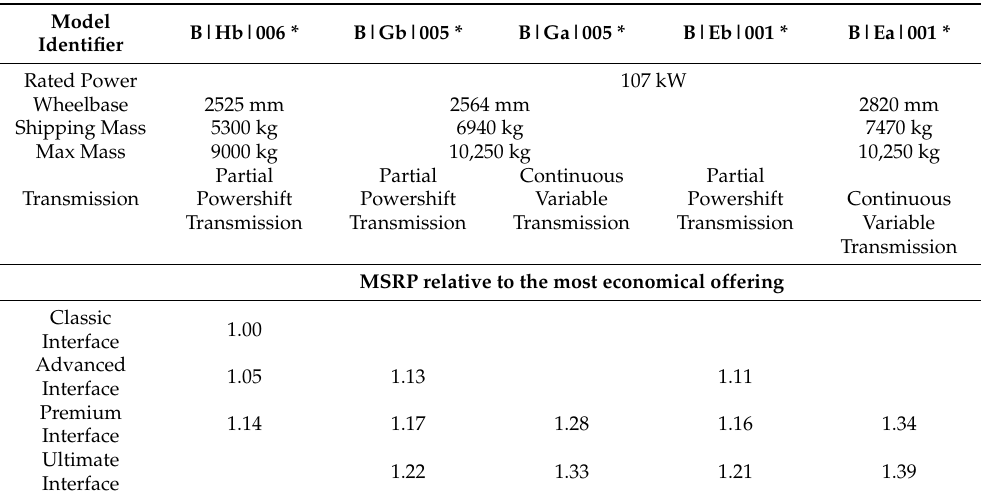
Table 2. Manufacturer’s suggested retail price (MSRP) for 107 kW from one brand relative to the most economical